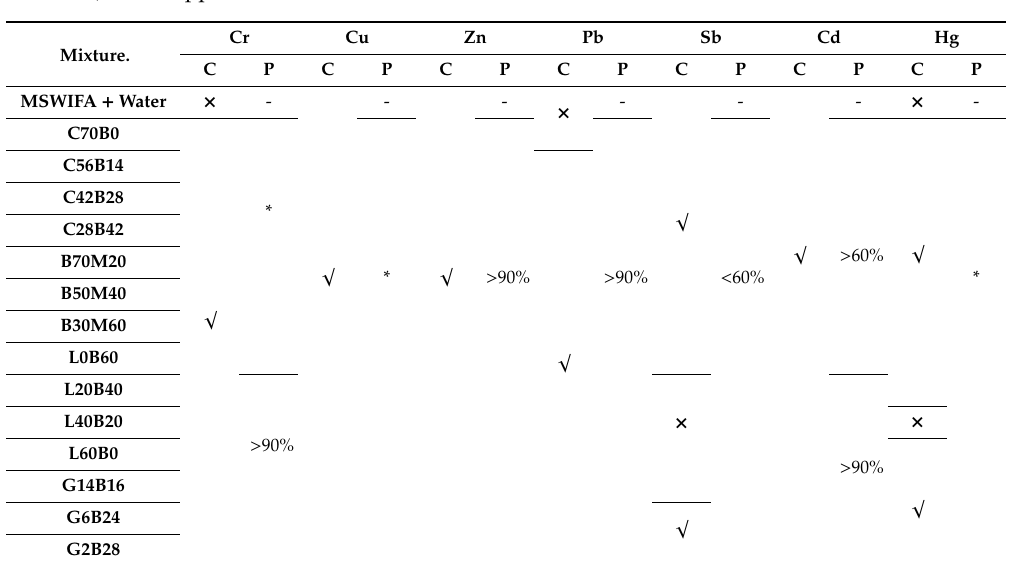
Table 4. The encapsulation performance for each heavy metal for all groups. The notations are